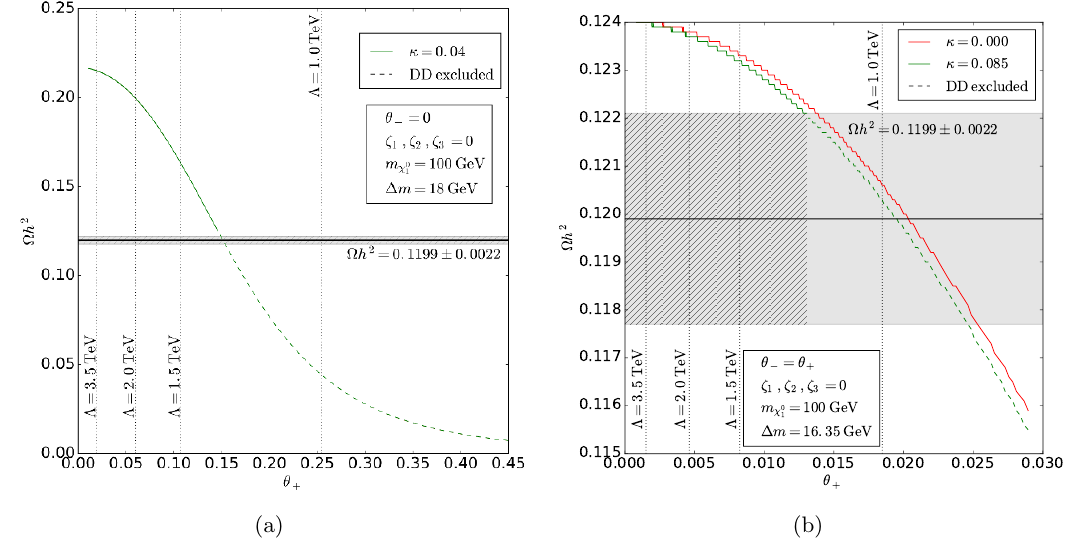
Figure 4 . The relic density as a function of the mixing angle (cid:18) + in the quadruplet model for m = 100 GeV. Left panel: (cid:18) (cid:0) = 0, representing the generic case of one dominant mixing angle. Right panel: the (cid:12)ne-tuned case (cid:18) + = (cid:18) (cid:0) . In the left panel, the curves for the maximal allowed value (cid:20) = 0 : 04 and for (cid:20) = 0 would be indistinguishable by eye, hence we plot only the former.